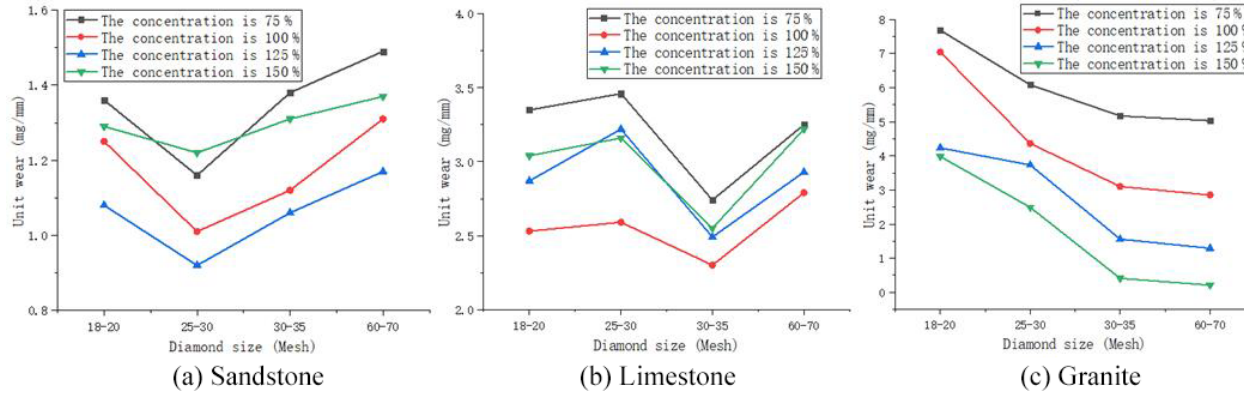
Figure 12. The unit wear of different rock samples.